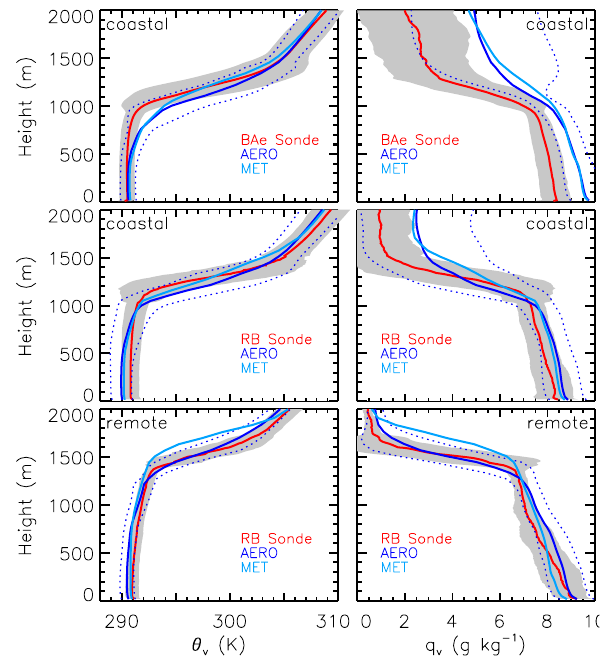
Fig. 1. Vertical profiles of virtual potential temperature ( θ v ) and water vapor mixing ratio ( q v ) measured by radiosondes released from the RB ship (red) and those from AERO (blue) and MET (light blue) simulations. The shaded area represents ± 1 σ of the obser- vations. The dash blue lines also indicate the ± 1 σ of the AERO simulations. Numbers of observational profiles used for the averag- ing are 31, 54, and 23 for panels in top, middle, and bottom rows,